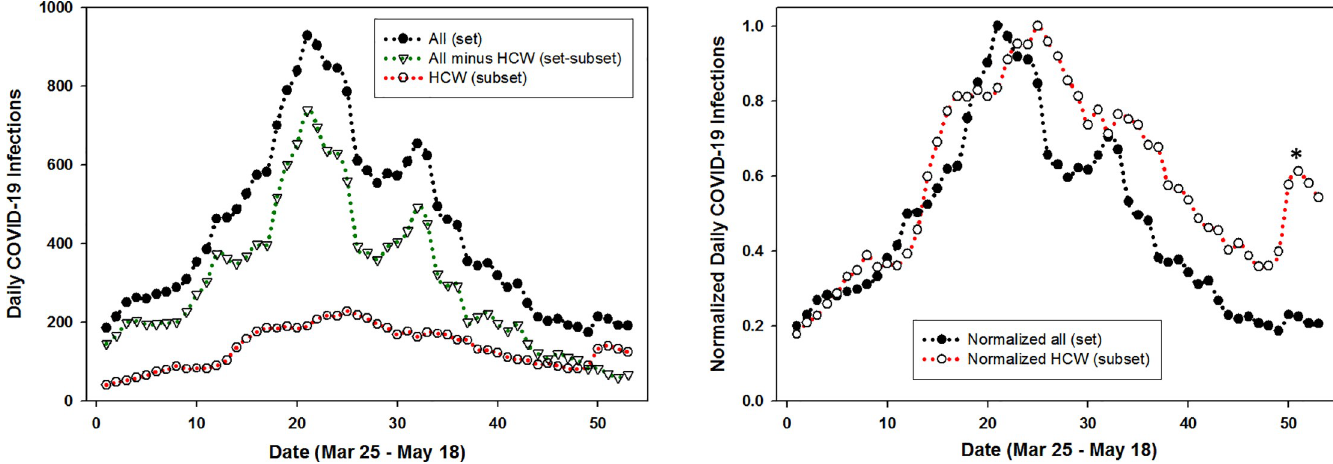
Fig 6. Left: Plot of five-day averaged daily COVID-19 infections for the entire population (set, solid circles); HCWs (subset open circles); and entire population minus HCWs (set–subset, triangles). Right: Plot of normalized five-day averaged daily COVID-19 infections for the entire population (set, solid circles) and HCWs (subset open circles) between Mar 25—May 18 in Ireland. � Reference